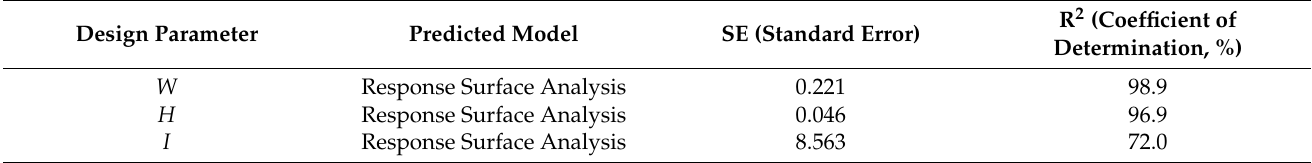
Figure 9. Comparison between measured and predicted welding factors according to mathematical model: ( a ) Top-Bead width, ( b ) top-Bead height, and ( c ) impact energy. Table 12. Analysis of variance tests for predicted model for welding